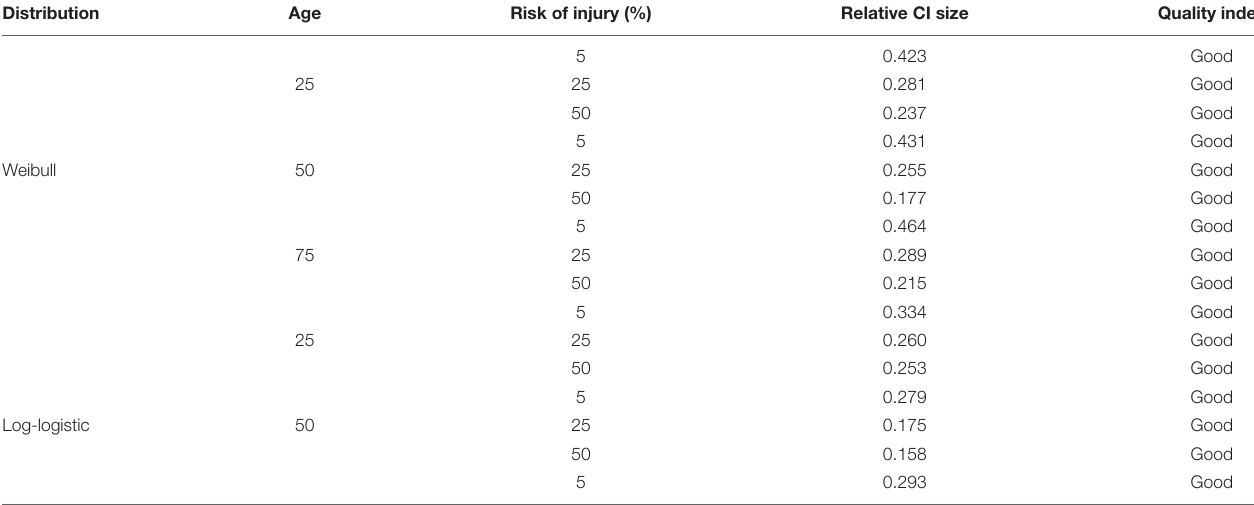
TABLE B2 | Relative size of 95% confidence interval and the corresponding quality index (QI) for Weibull, log-normal, and log-logistic